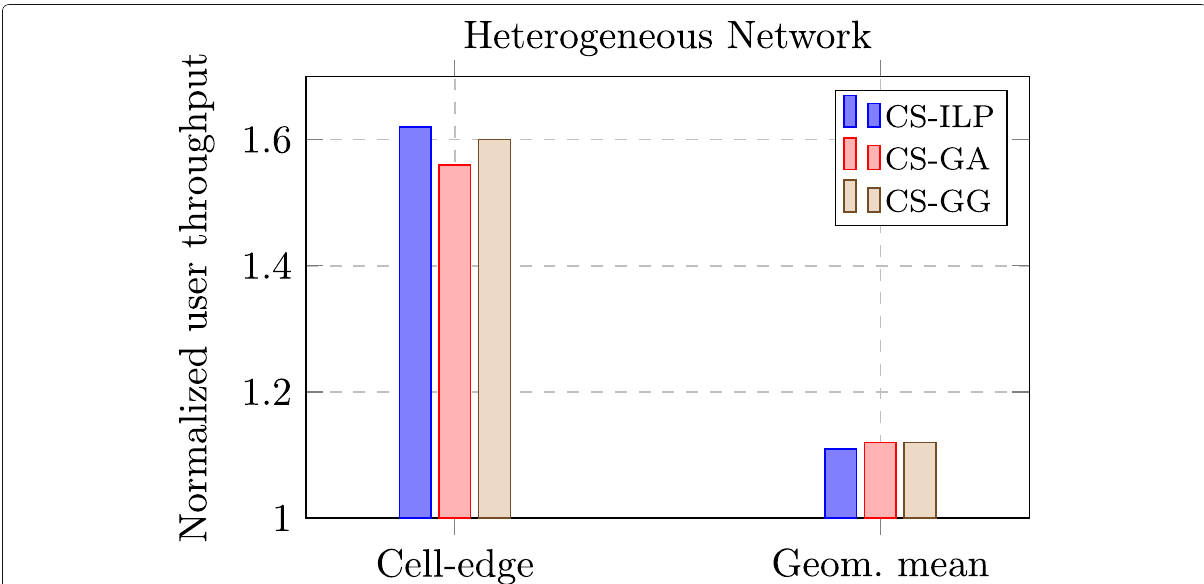
Fig. 6 Cell-edge and geometric mean of the average user throughput, normalized with respect to the non-coop. PFS, for a scenario with M = 42 BSs, N = 630 UEs, L = 10 PRBs, and M (cid:4) = 2 BSs, with wrap-around technique. Results from system level simulations of a heterogeneous network